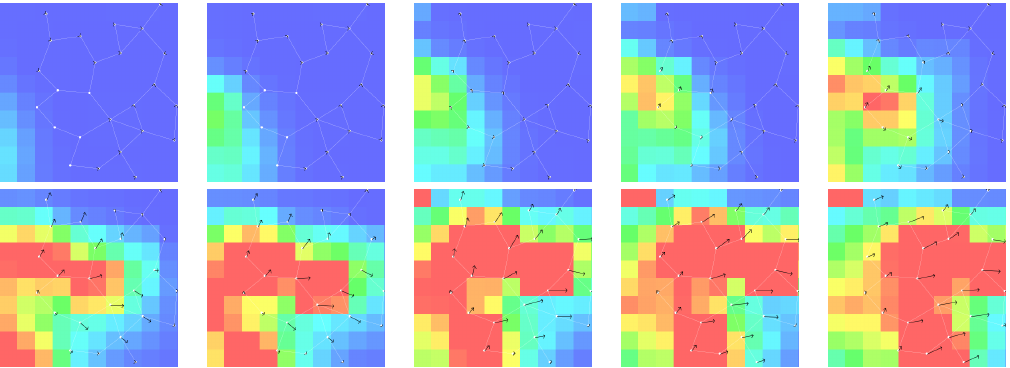
Figure 9. Time series of radar images separated by 1 min from the upper left to the lower right for the first rain cloud in the event (Time Steps 14 to 23). Simulated sensor network of n = 25 nodes, a communication range of r = 2000 m and estimated motion